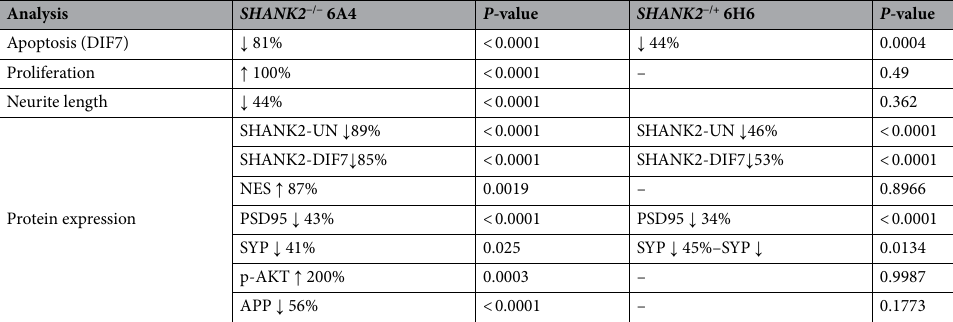
FACS Aria II SORP system. After 1–3 months, colonies could be split and analyzed for mutations. Medium changes were performed weekly. Quantitative real time PCR (qPCR).